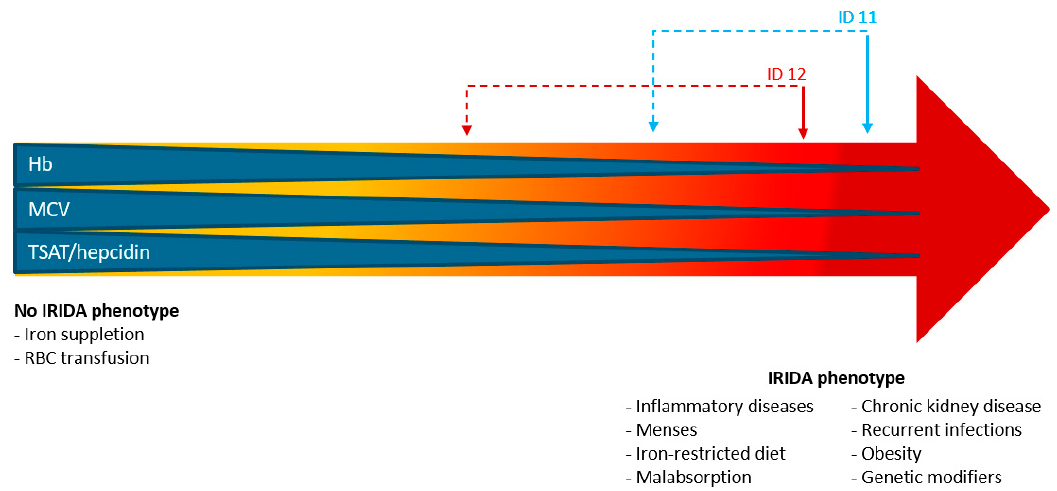
Figure 2. Proposed model for the potential effect of environmental and (epi)genetic factors on IRIDA phenotype expression in TMPRSS6 monoallelic ‐ affected subjects . Expression of IRIDA phenotype displayed as a sliding scale. The more to the right, the more pronounced the phenotype. Presence of modulating factors, including environmental and (epi)genetic factors, contribute to a more severe phenotype (right part of arrow). Treatment can improve phenotype (left part of arrow). Model is illustrated by two patients: ID 11, presented with Giardia lamblia infection and severe anemia. After antibiotic treatment, anemia improved but still persisted; ID 12, suffered from heavy menstrual bleedings, which stopped after starting gonadorelin antagonist. In combination with IV iron administration, IRIDA phenotype became less pronounced.